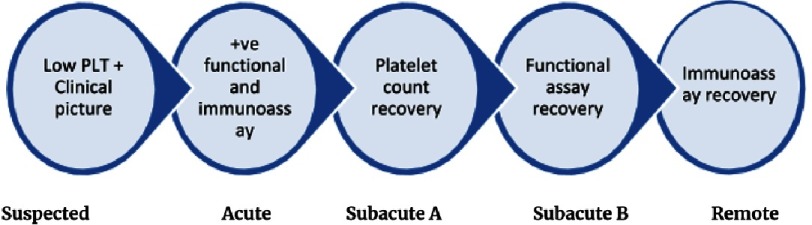
The 5 phases of HIT.